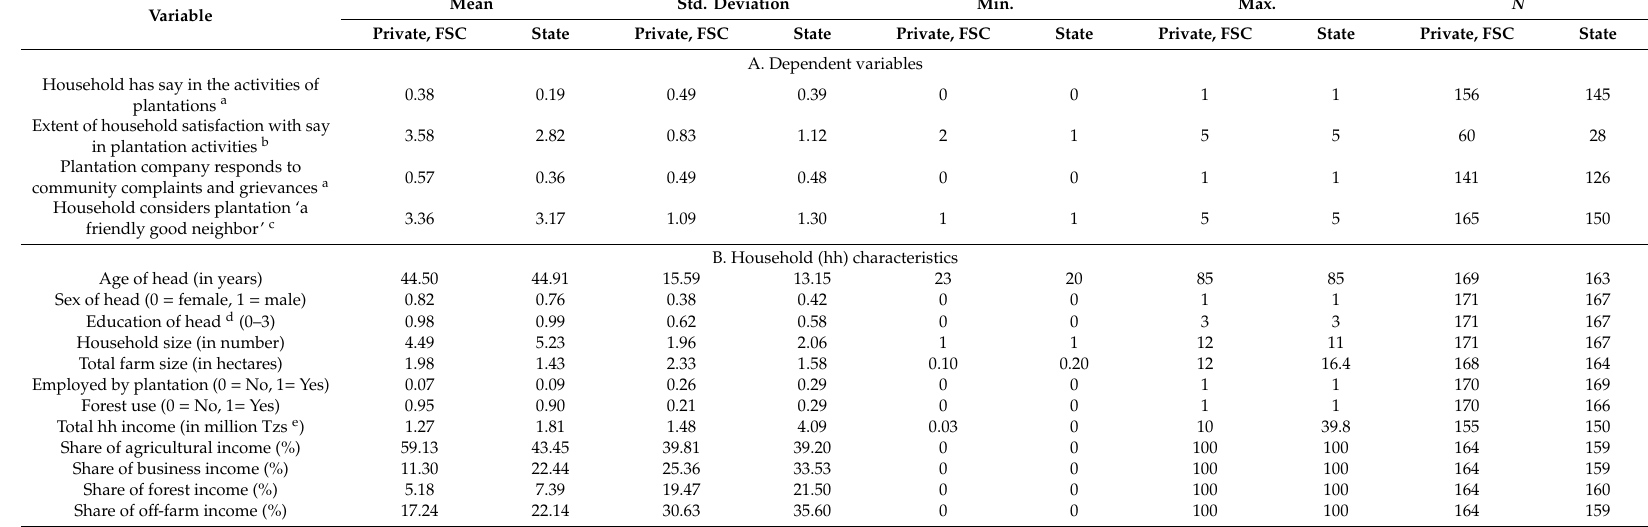
Table 2. Descriptive Statistics of